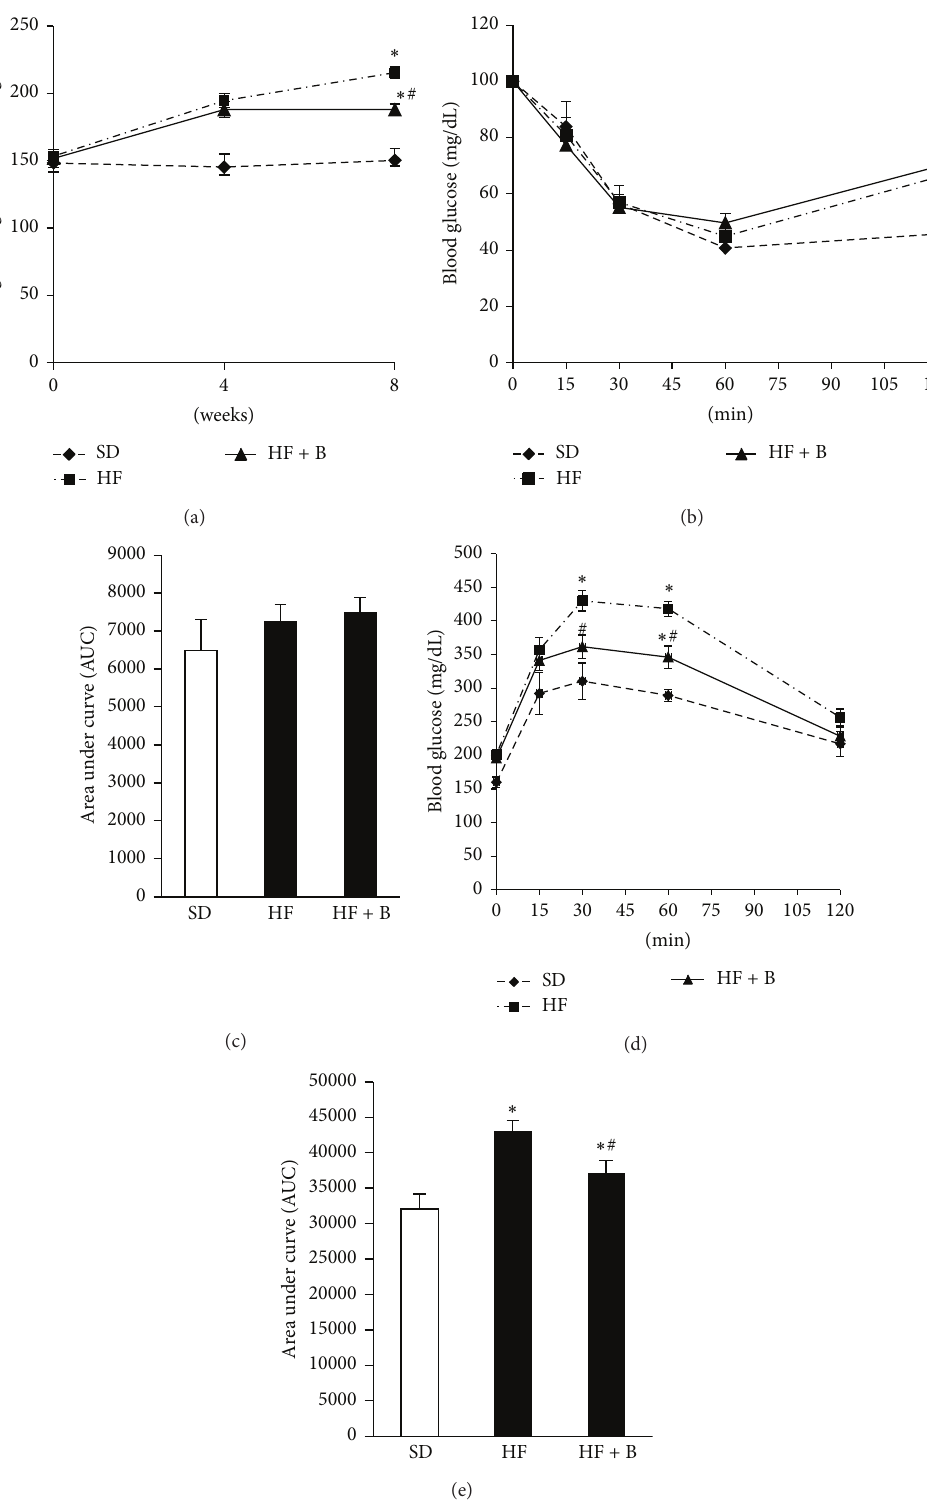
Figure 2: Dietary intake of baicalein improved glucose tolerance but did not affect insulin sensitivity in obese mice. Fasting blood glucose was monitored every 4wks (a). Insulin tolerance (b) and glucose tolerance tests (d) were performed as stated in the Methods section. The total values of area under the curve (AUC) for insulin (c) and glucose (e) tolerance tests were calculated. Data are means ± SE ( 𝑛 = 10 mice/group). ∗ 𝑃 < 0.05 versus SD group; # 𝑃 < 0.05 versus HF group. SD: standard diet, HF: high-fat diet, and HF + B: HF + 0.5 g baicalein/kg